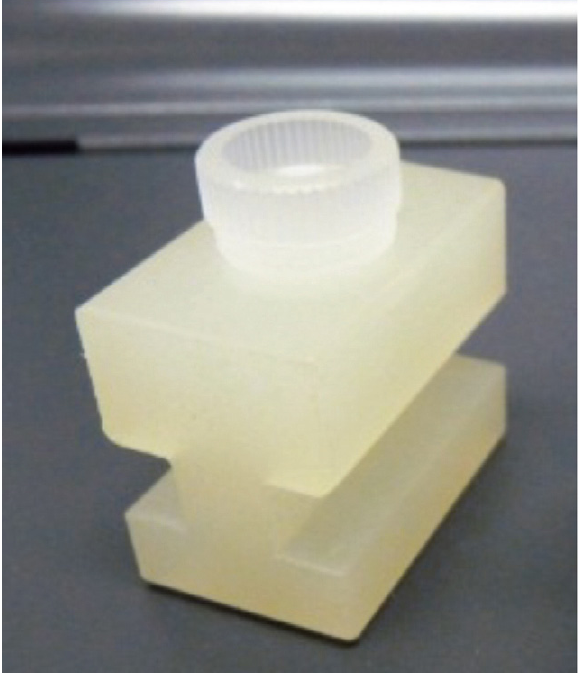
Figure 1. The manual injection kit